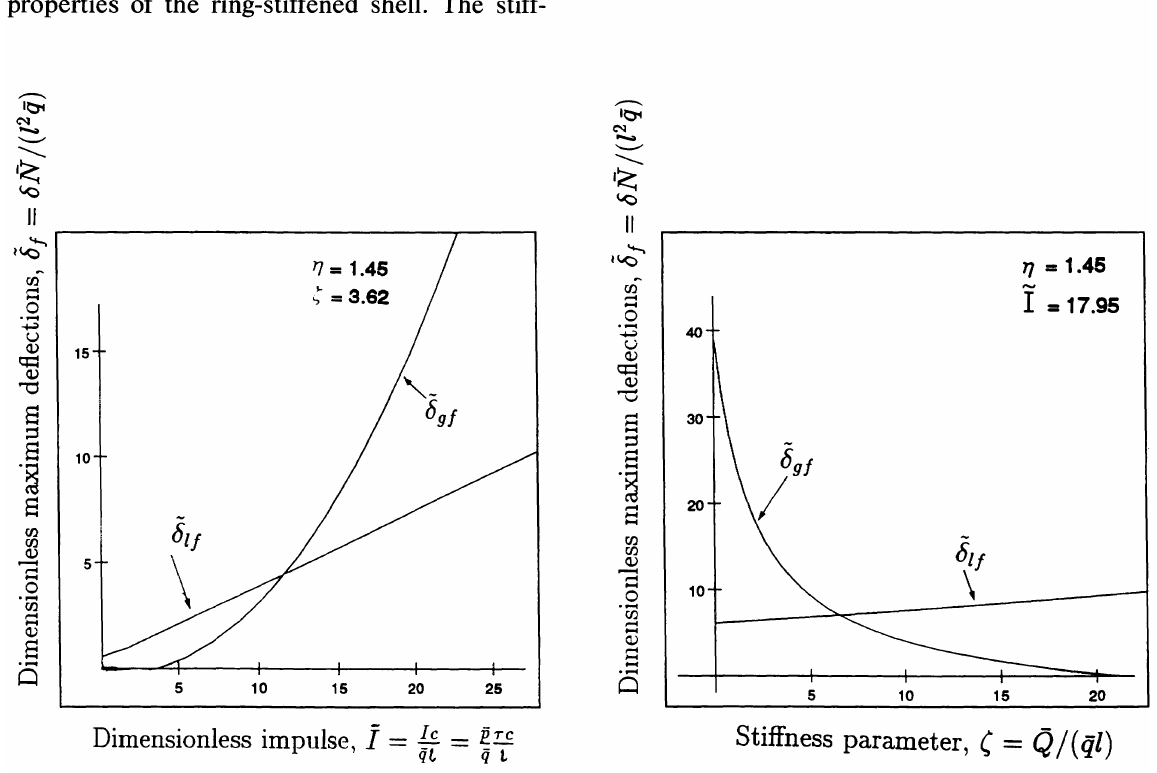
FIGURE 10 Maximum deflection versus stiffness